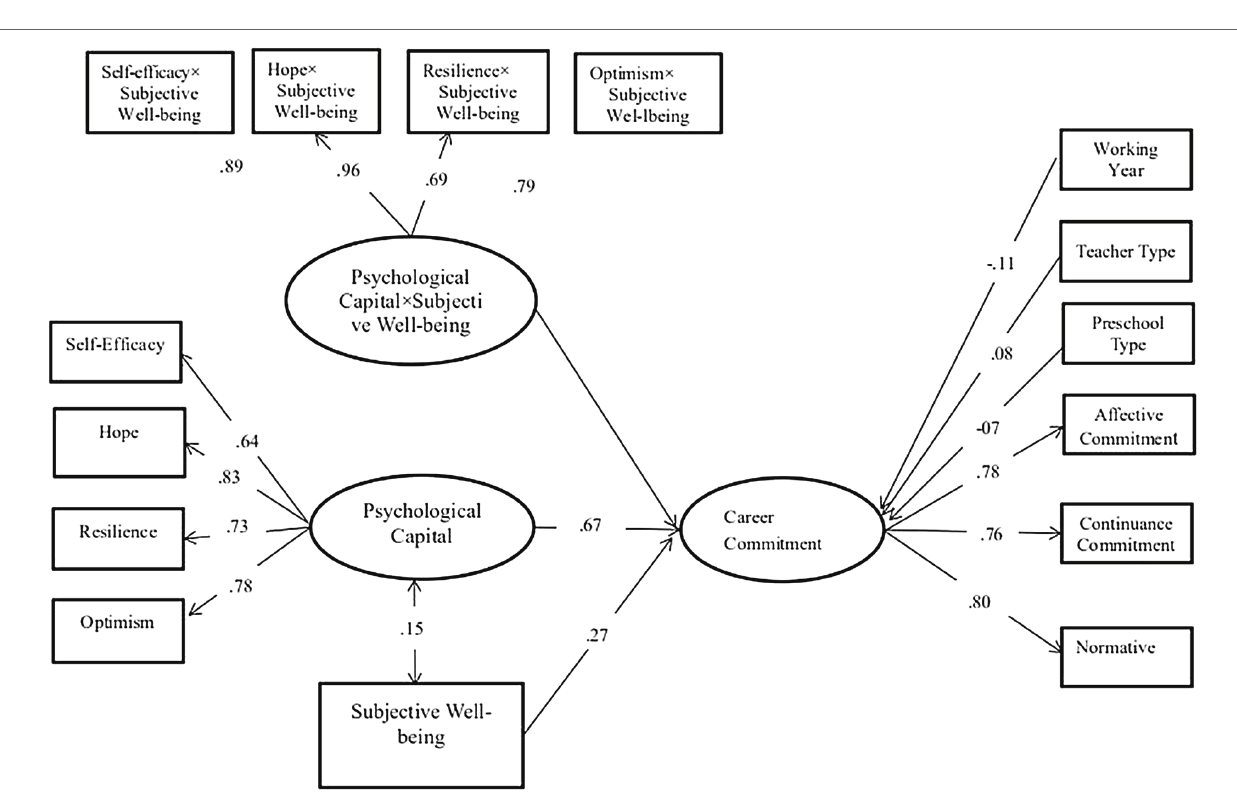
FIGURE 3 | Associations between PsyCap, SWB, and career commitment ( N = 759). Significant standardized coefficients were presented. Nonsignificant coefficients were not